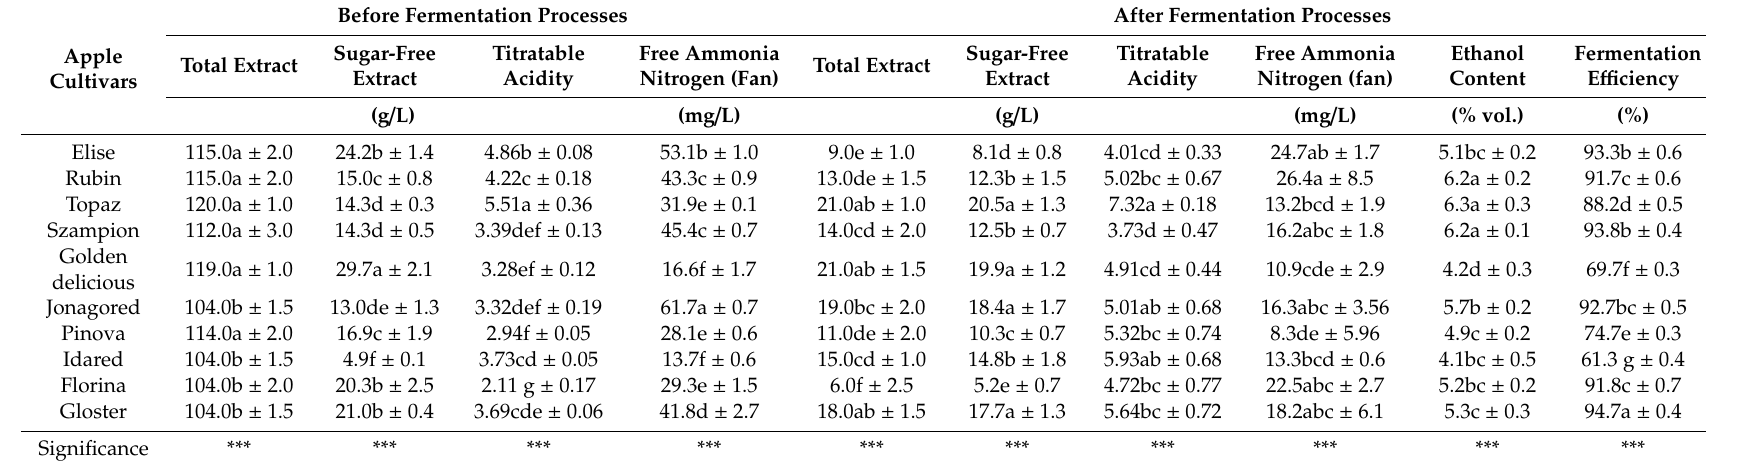
Table 2. Selected chemical parameters of fresh and fermented musts obtained from various apple